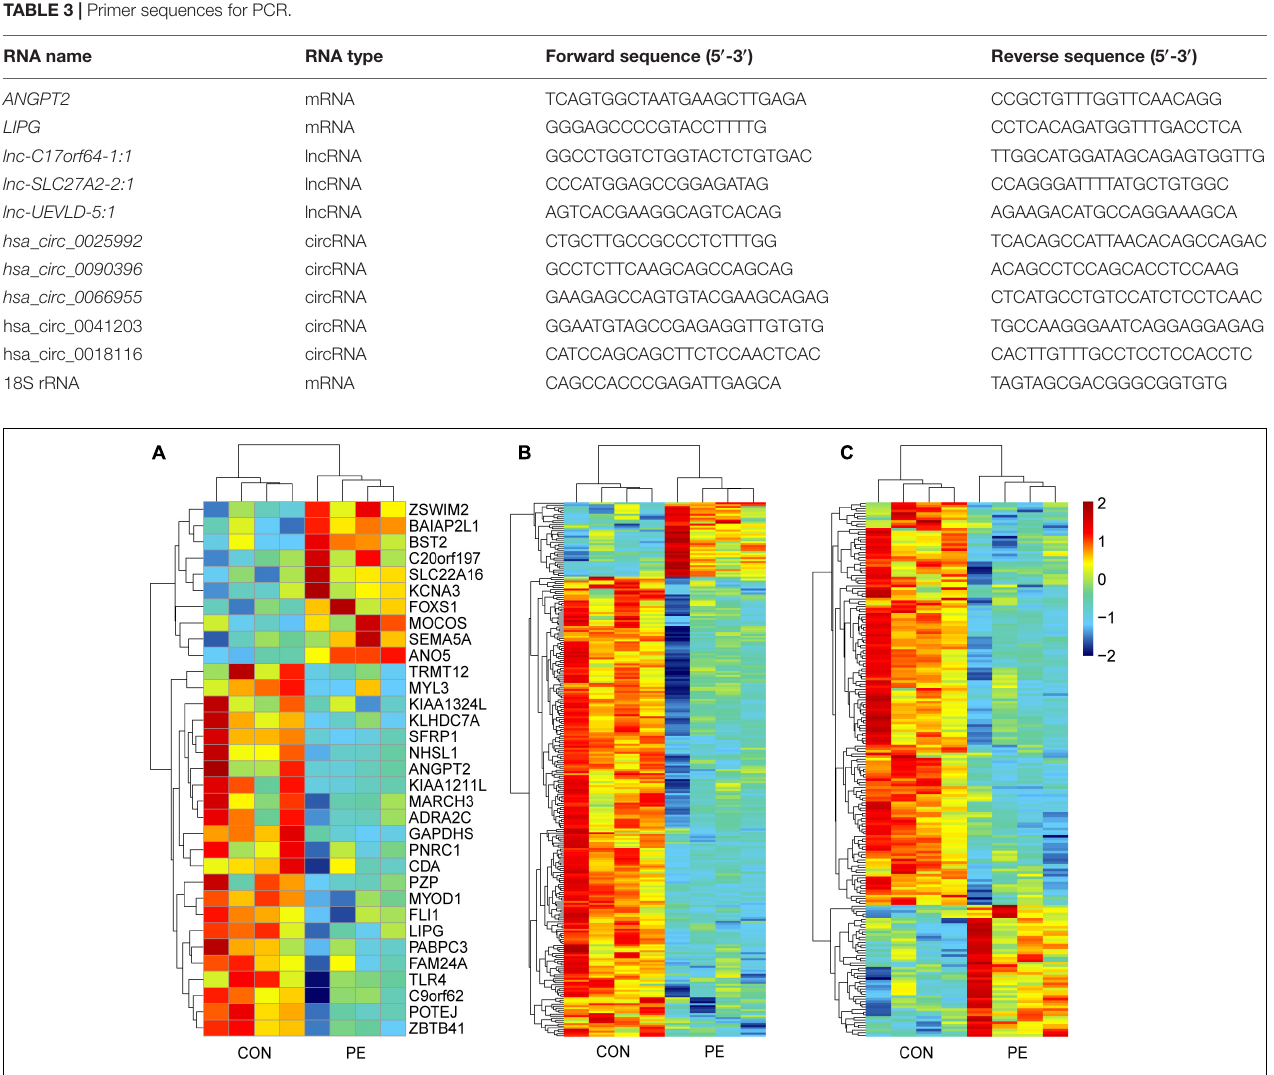
FIGURE 1 | Hierarchical clustering analysis of DERNAs in HUVECs between normal pregnancies and PE patients. The heatmap reveals 33 DEmRNAs (A) , 272 DEcircRNAs (B) , and 207 DElncRNAs (C) . Each column and row correspond to a sample and a transcript, respectively. Red represents upregulation, while blue represents downregulation. CON, control; PE, preeclampsia, n =